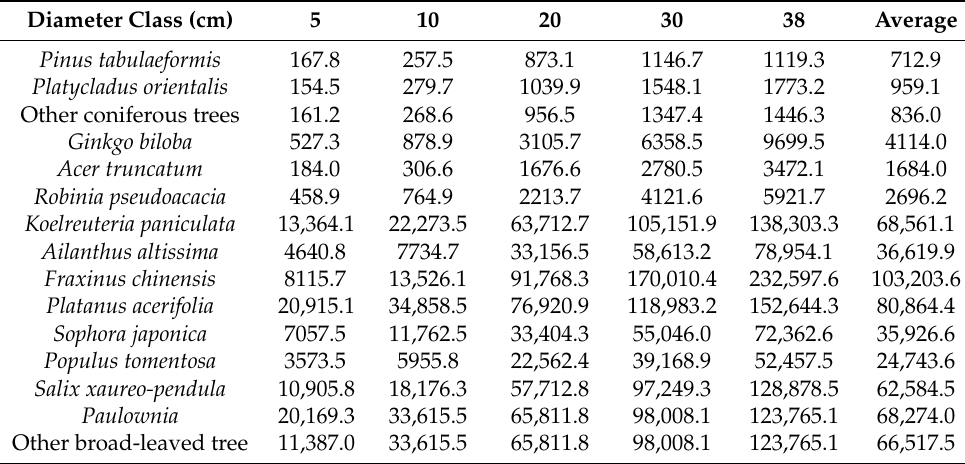
Table 8. Annual water consumption of individual trees in different diameter classes